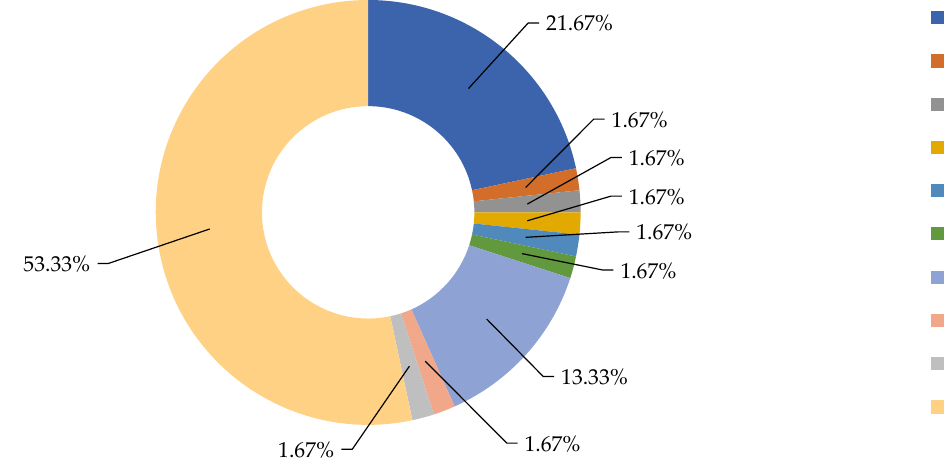
Figure 5. Distribution and characteristics of traumatic laryngeal injuries that required a surgical therapeutic approach. A—vocal cord injuries. B—arytenoid cartilage injuries. C—cricoid cartilage fracture. D—cricotracheal membrane section. E—section thyroyidian membrane. F—paralaryngian hematoma. G—total or partial thyroid cartilage fractures. H—section thyrohyoid membrane, epi-